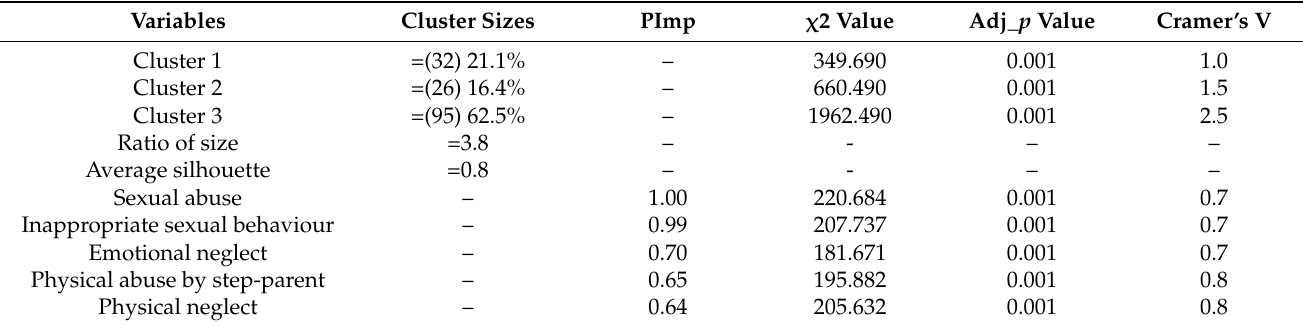
Table 5. The two-step cluster model that classifies the adverse childhood experiences amongst homeless people according to the ratio of size, the average silhouette of the model, PImp values, χ 2 values, and variable-specific Cramer’s V values.